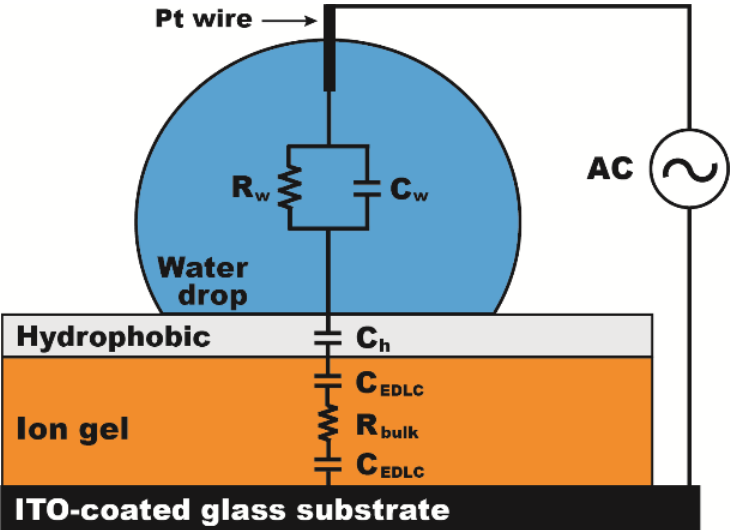
Figure 1. An experimental setup for alternating current (AC) electrowetting study with the ion gel. To investigate the gel layer effect on AC electrowetting, a 15 µ L de-ionized water drop is placed on the ion gel layer covered by a thin hydrophobic layer. An equivalent circuit for the gel layer can be modelled as two capacitors ( c EDLC ) serially connected with a resistor ( R bulk ). A water drop is equivalently modelled as an impedance formed with a resistor ( R w ) and a capacitor ( c w ) connected in parallel, while a hydrophobic layer is modeled as a single capacitor ( c h